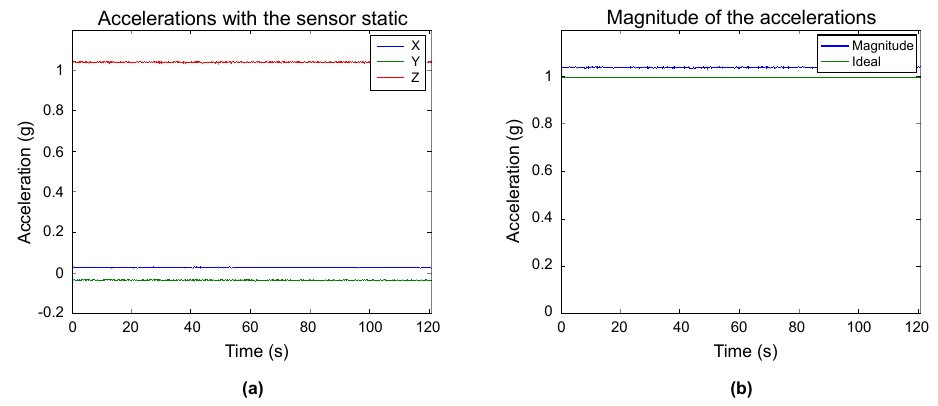
Figure 7. Preliminary evaluation of the sensor. ( a ) measurements when the sensor is static with the z -axis pointing to the ground; ( b ) magnitude of the